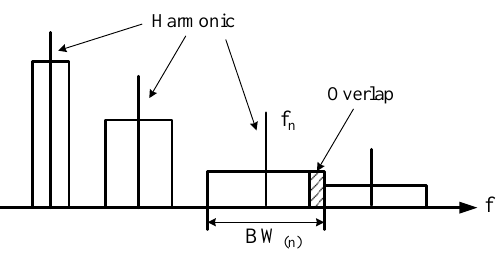
Figure 5. Boundary superposition of high-order sub-harmonic waves in modulated wave spectra.